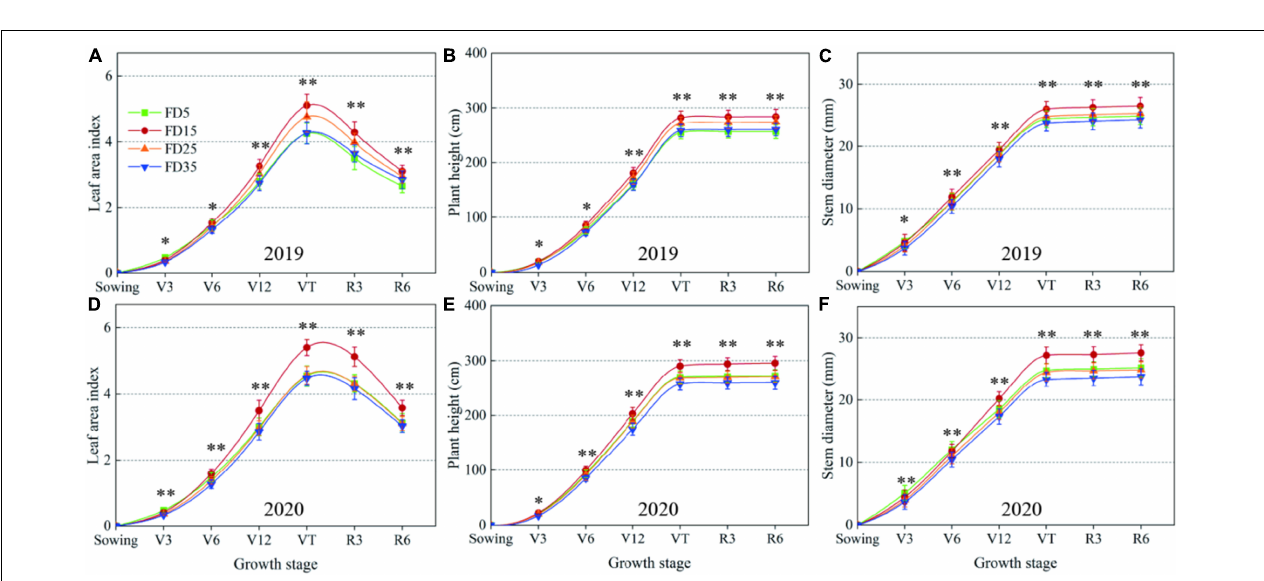
FIGURE 6 | Effects of fertilizer application depths on leaf area index (A,D) , plant height (B,E) and stem diameter (C,F) of summer maize in 2019 and 2020. FD5, fertilizer application at a depth of 5 cm; FD15, fertilizer application at a depth of 15 cm; FD25, fertilizer application at a depth of 25 cm; and FD35, fertilizer application at a depth of 35 cm. The vertical bars stand for standard deviation. ns, no significant difference; ∗ , significant at P < 0.05; ∗∗ , significant at P < 0.01.